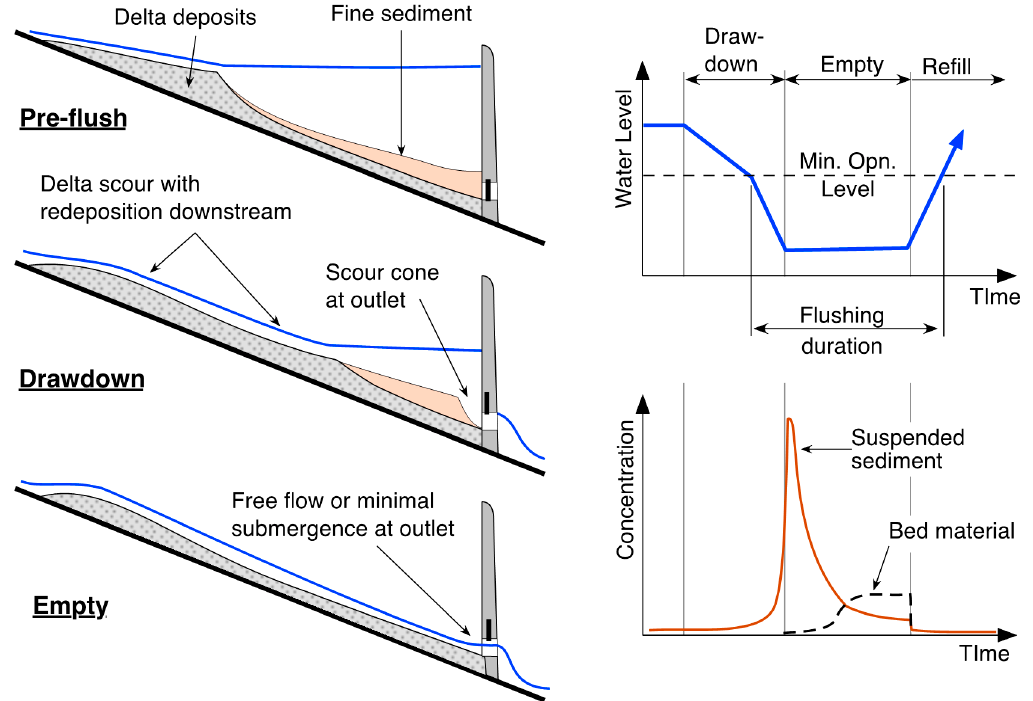
Figure 11. Reservoir flushing sequence.